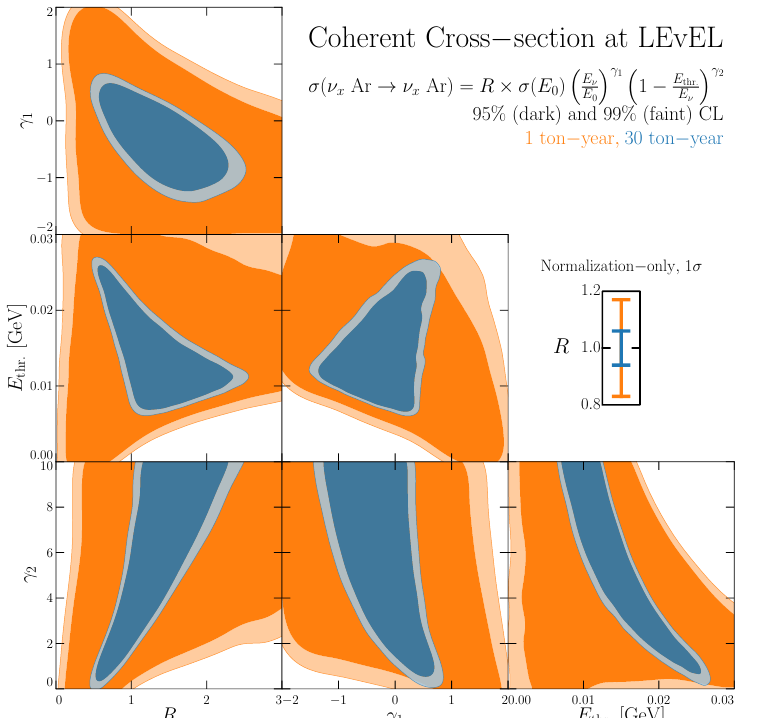
Figure 8. Measurement capability of LEvEL for the coherent scattering cross section on argon assuming a signal-to-background ratio of 1 and systematic uncertainties (5% overall flux uncertainty and 10% kaon-to-pion production ratio uncertainty) marginalized over. Both a 1 ton-yr (orange) and a 30 ton-yr (blue, assuming a 10 ton-scale detector operating for 3 years) are considered. Here we parameterize this cross section as given in eq. (4.4) and given in the top-right of this figure. For both exposures, we display 95% (darker colors) and 99% (fainter) credible regions, as extracted using the Bayesian inference tool PyMultiNest [131, 132]. The inset displays the extracted ± 1 σ measurement of R when only constraining the cross-section normalization, i.e. when γ 1 , γ 2 , and E thr . are